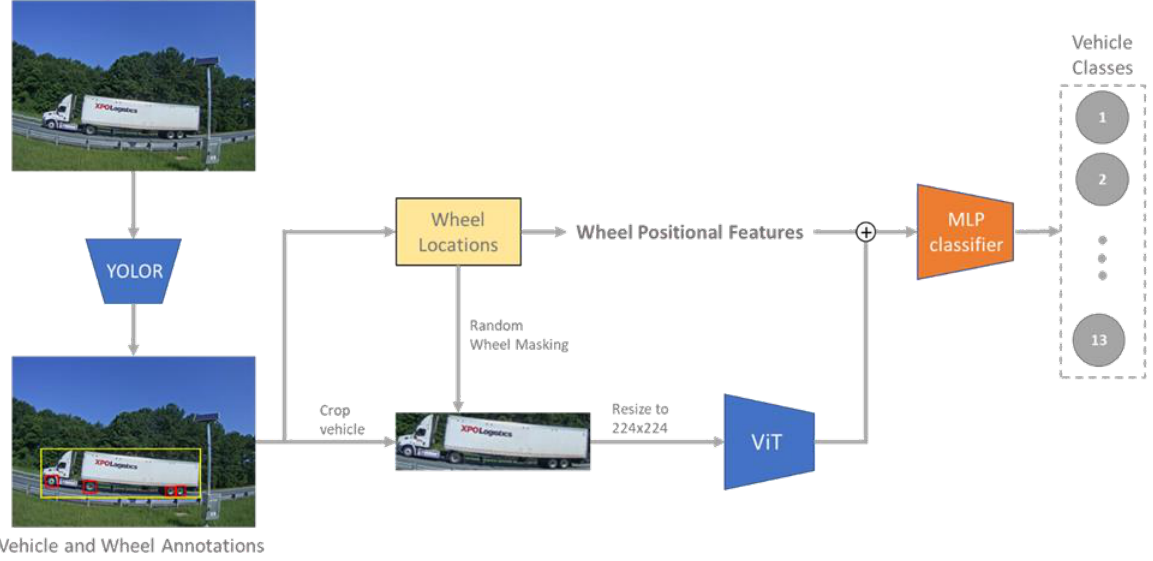
Figure 7. Structure of the composite model